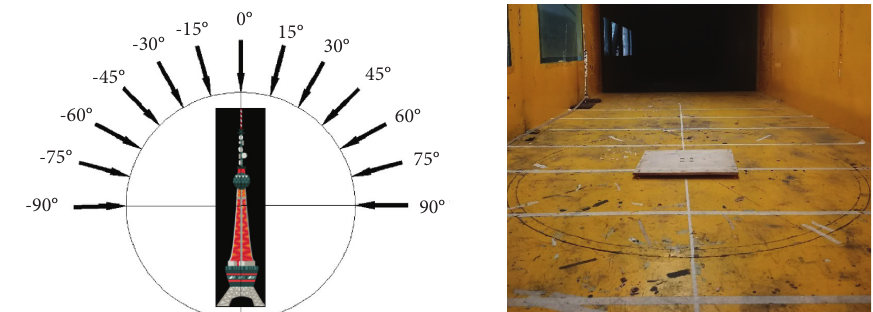
Figure 6: Definitions of the coordinate system and wind direction.